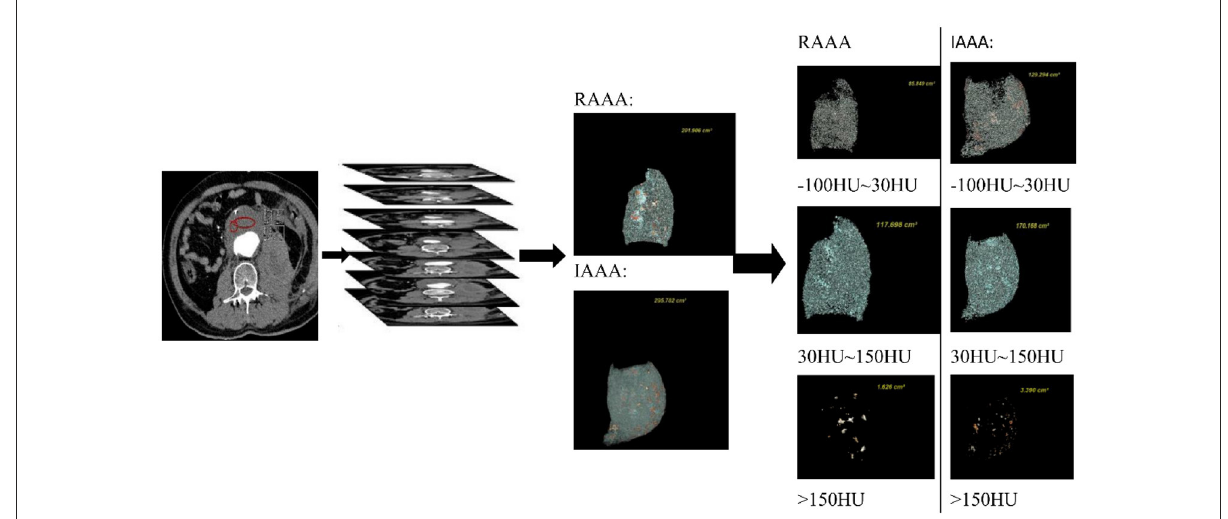
FIGURE3 The procedure of measuring CT values at the maximum transverse diameter and calculating thrombus volumes in the range of different CT in IAAA and RAAA.